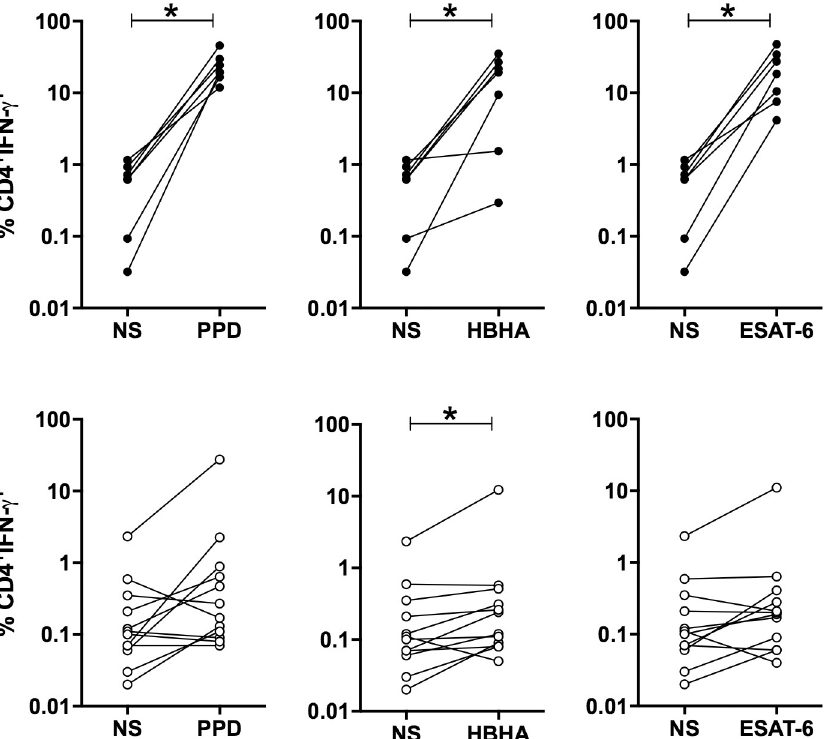
Fig 1. Percentages of IFN- γ + CD4 + T lymphocytes among non-stimulated (NS) compared to mycobacterial antigens-stimulated ascites lymphocytes. The percentages of IFN- γ -containing CD4 + lymphocytes were measured by flow cytometry after an overnight in vitro culture of the ascites lymphocytes left non-stimulated (NS) or stimulated with PPD (left panels), HBHA (middle panels) or ESAT-6 (right panels) for TB (upper panels) and non-TB patients (lower panels). Individual values obtained for each patient for lymphocytes left unstimulated and those stimulated with a mycobacterial antigen are linked. NS, non-stimulated. Results obtained in the presence or absence of antigens were compared by the Wilcoxon test � , P <